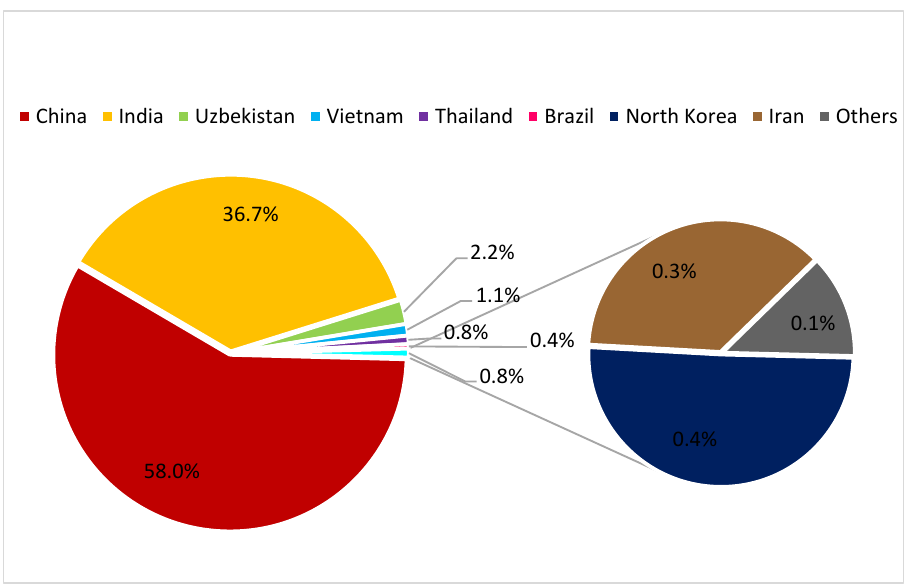
Figure 2. Pie-chart and relative shares of global silk production (data from https://inserco.org/en/statistics; accessed on 23 November 2021) in 2020; China and India alone cover more than 90% of the worldwide production (94.7%).